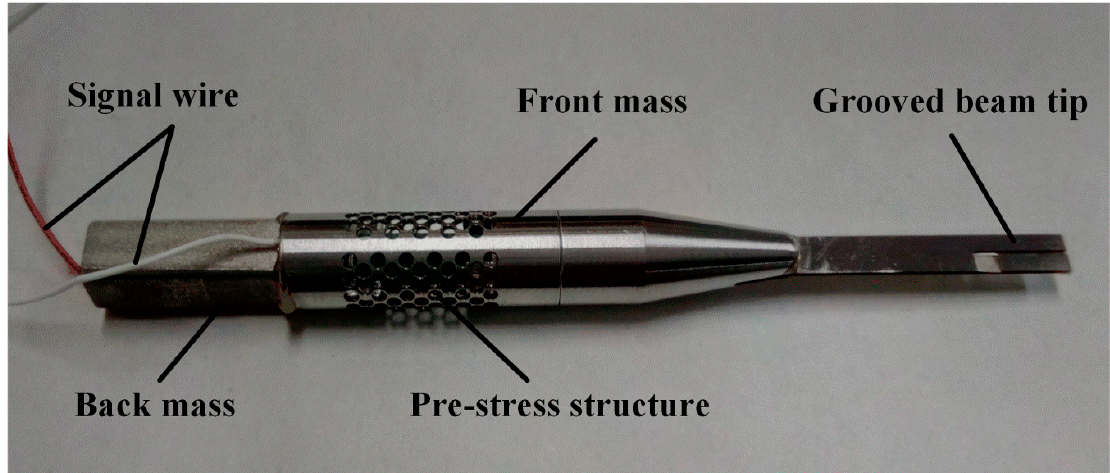
Figure 7. The vibration trajectories of an actuator with a beam tip of 9 mm.